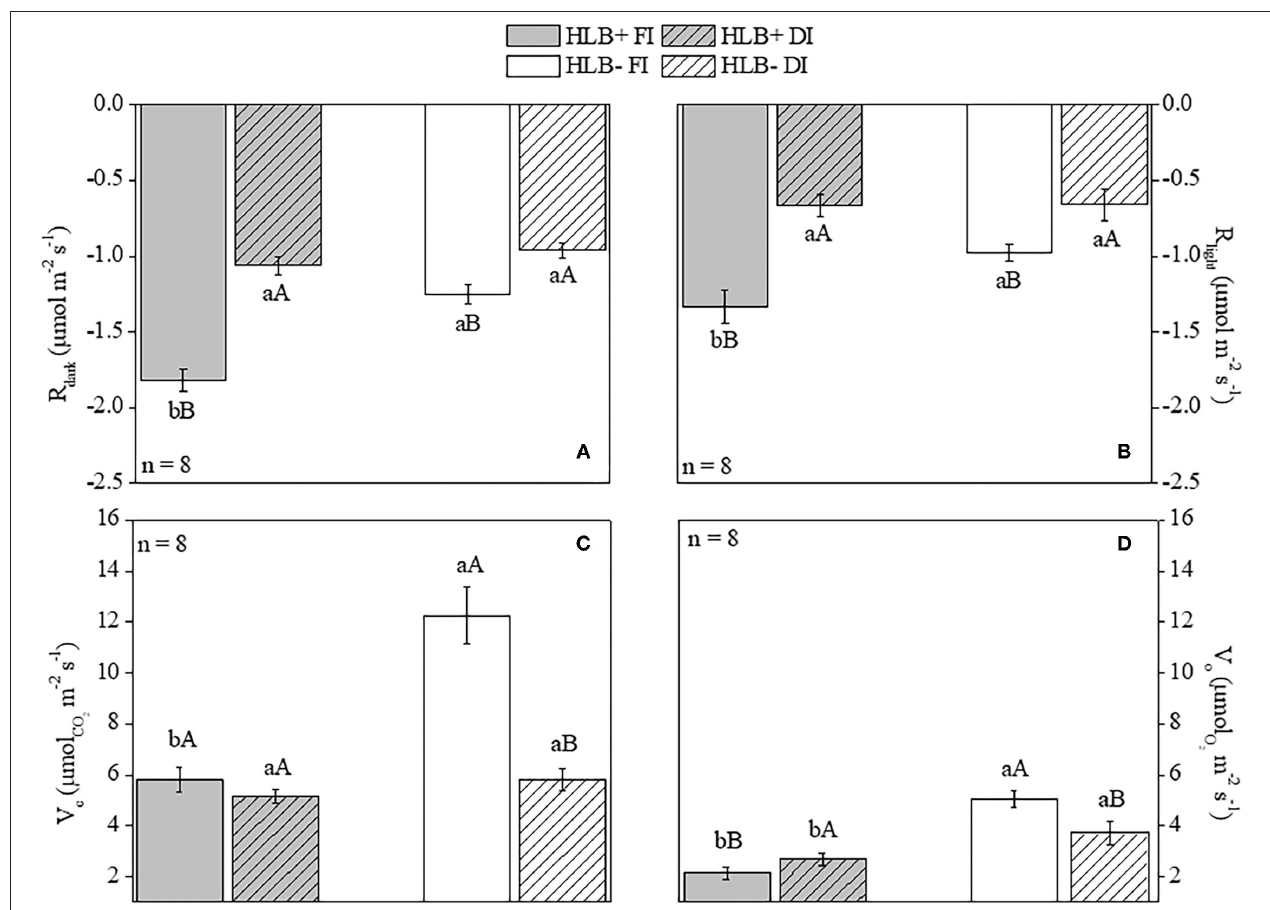
FIGURE 4 | Leaf respiration in the dark [ R dark , (A) ] and in the light [ R light , (B) ], and Rubisco carboxylation [ V c , (C) ] and oxygenation [ V o , (D) ] rates of “Valência” orange trees [ Citrus sinensis (L.) Osbeck] grafted on citrumelo “Swingle” rootstock [ Citrus paradisi Macfad. x Poncirus trifoliata (L.) Raf.] either infected with “ Ca . Liberibacter asiaticus” ( + ) or healthy (–) and exposed to two water management treatments: fully irrigated (FI) and deficit-irrigated (DI). Values are mean ± SE ( n = 8). Means followed by the same letter do not differ between water management treatments within the same HLB infection conditions (upper case) or between HLB infection conditions within the same water management treatment (lower case) according to unpaired Student’s t -test at 5%